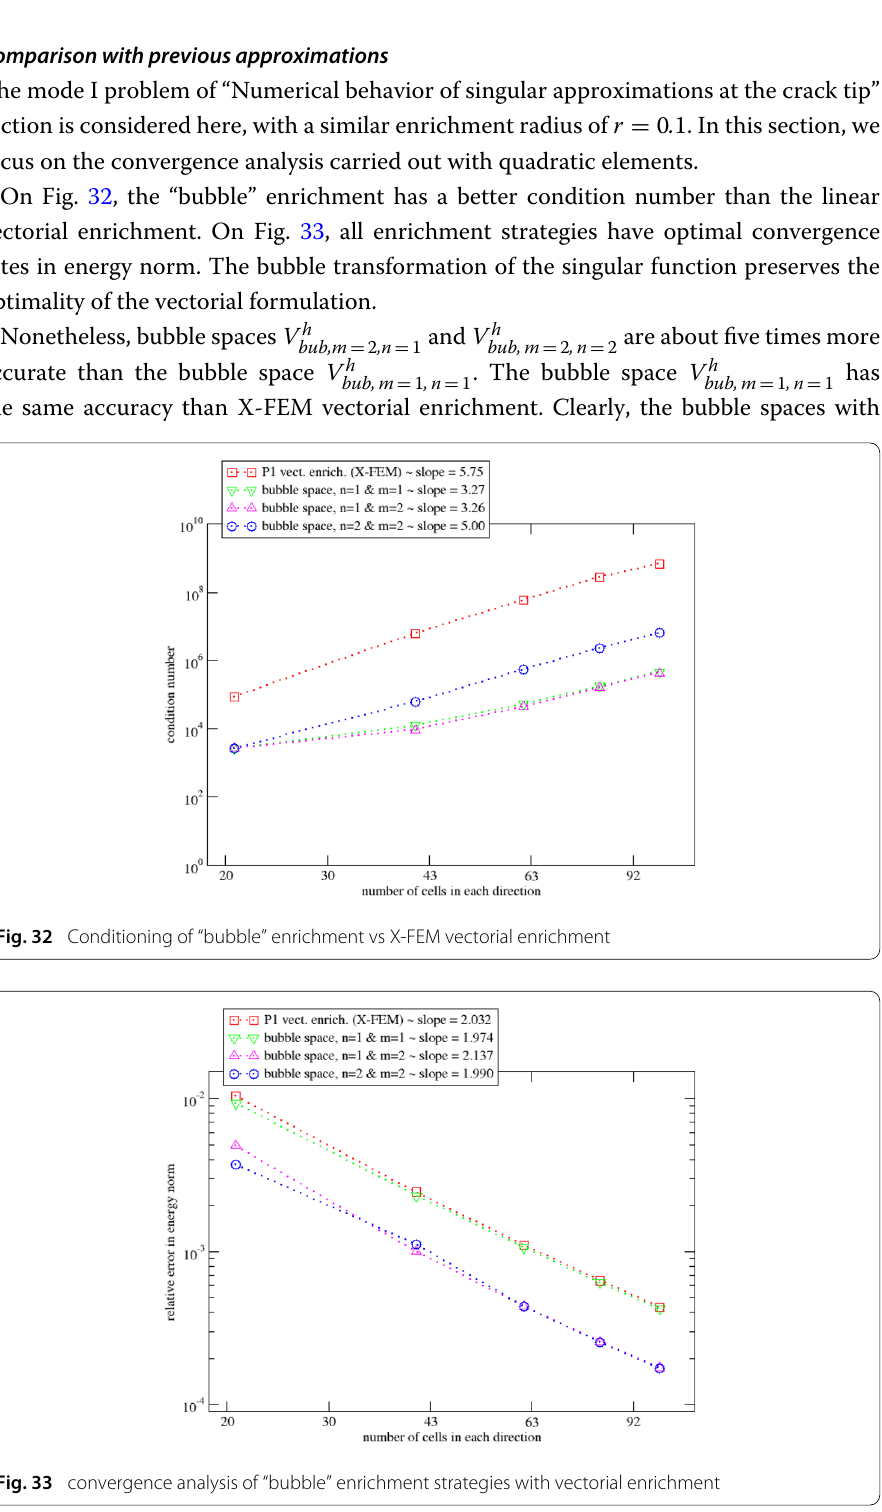
Fig. 33 convergence analysis of “bubble” enrichment strategies with vectorial